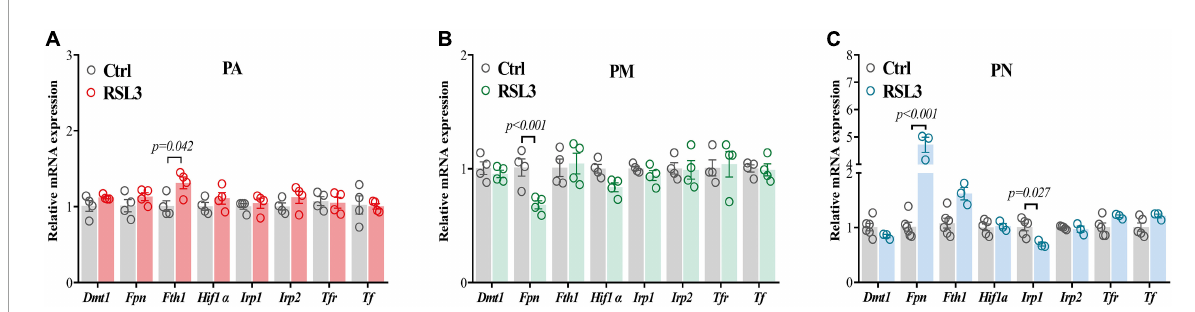
FIGURE3 Iron metabolism-related gene expressions in primary brain cells after RSL3 treatment. (A–C) qPCR was performed to quantify the mRNA levels of iron metabolism-related genes in PA (A) , PM (B) and PN (C) after 24 h of RSL3 treatment, respectively. Data are means ± SEM, N = 3–5. Student’s t -test was